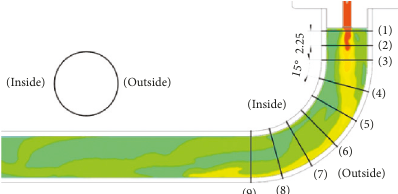
Figure 8: The diagram of section